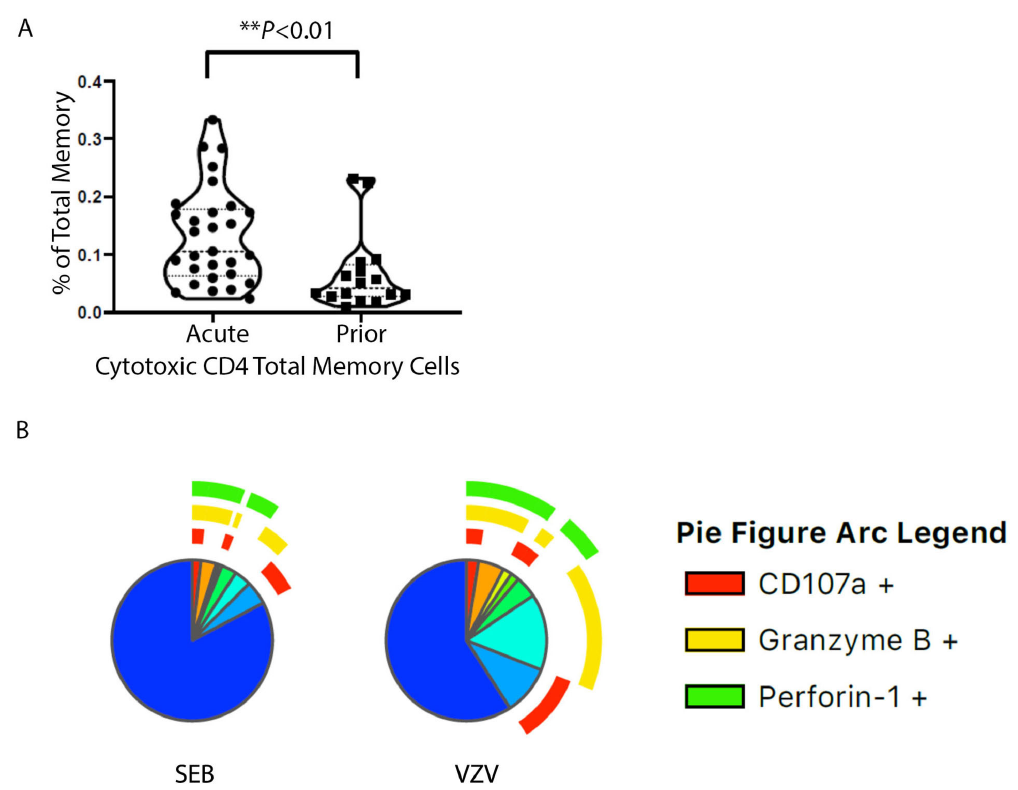
Figure 3. (A) Violin plots for cytotoxic CD4+ T-cell percentages in total memory CD4+ T cells responding to VZV stimulation cytotoxic CD4+ T-cell percentage of total memory CD4+ T cells. Each dot represents a unique individual. (B) Pie charts showing the proportion and expression pattern of CD4+T-cell cytotoxic function after SEB or VZV stimulation in all individuals. Blue region without arcs depicts non-cytotoxic